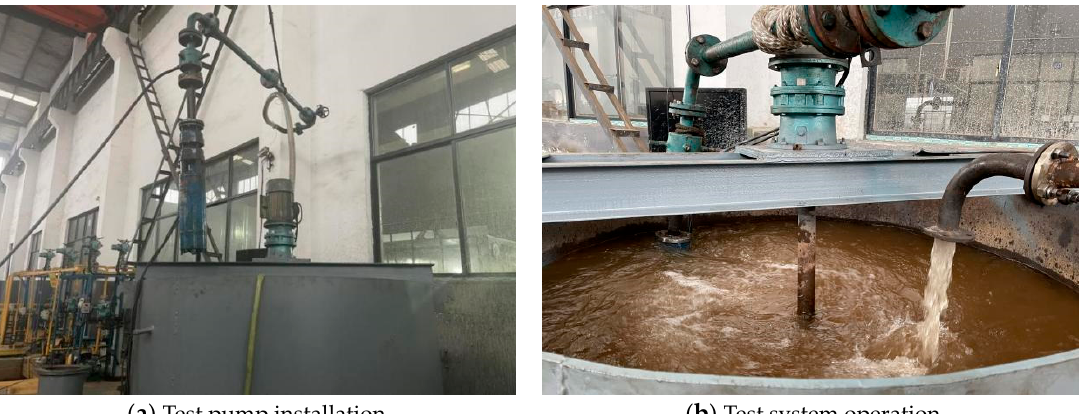
Figure 26. Test site.